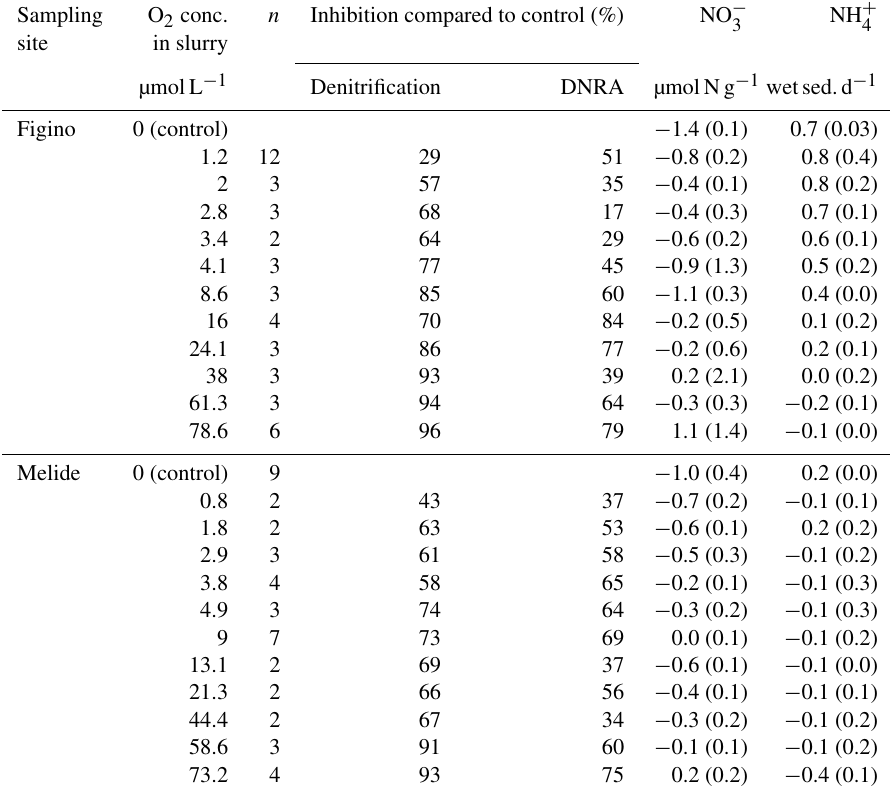
Table 1. Overview of N transformation rates in O 2 -controlled slurry incubation experiments. Negative and positive values correspond to net NO − or NH + consumption and production over incubation time, respectively. Standard errors are indicated in brackets for n replicates. 3 4